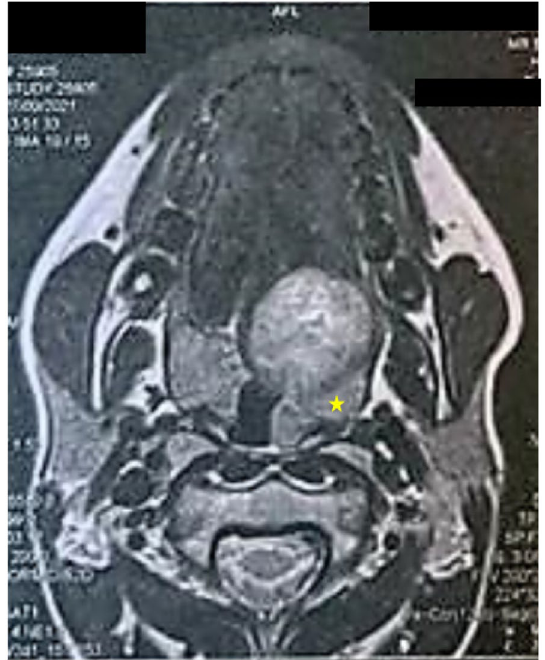
Fig. 3 MRI T2 axial view showing a submucosal hyper-intense heterogeneous tongue base mass with close contact with the lingual tonsil (star)